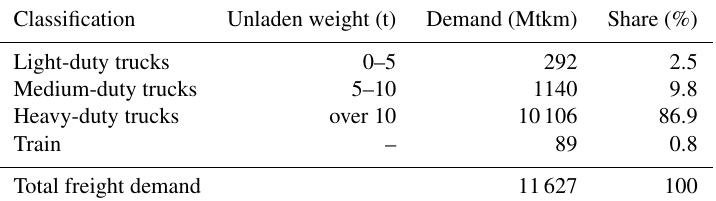
Table 5. Freight demand in 2018 (CSO, 2020g, h,